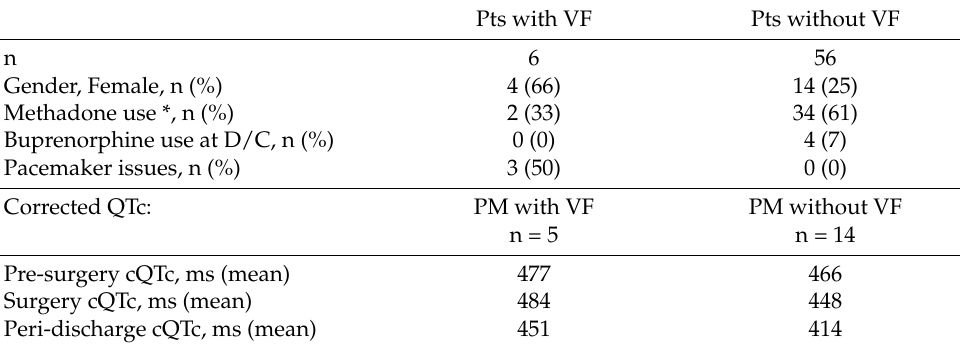
Table 3. Characteristics of patients with and without